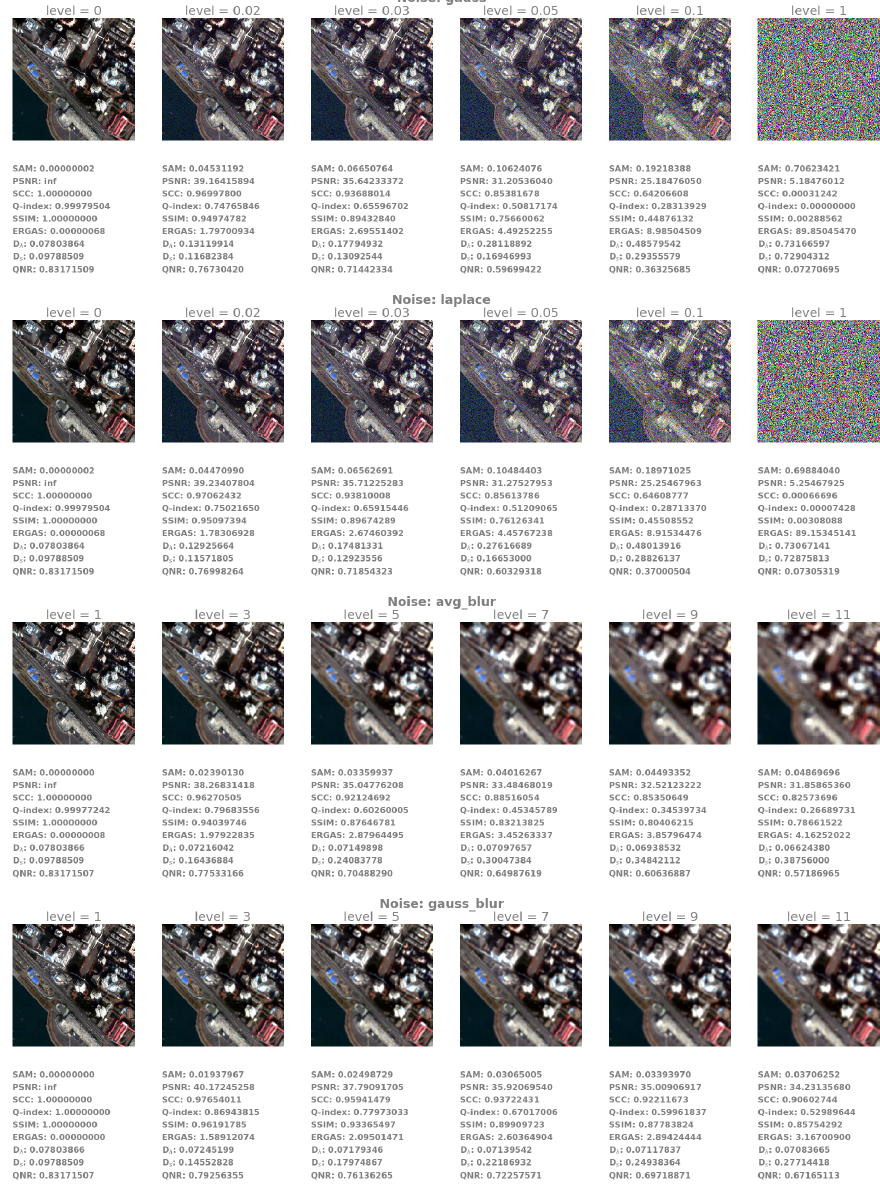
Figure A1. Noised images and the corresponding image quality assessment scores. Greater level value means stronger